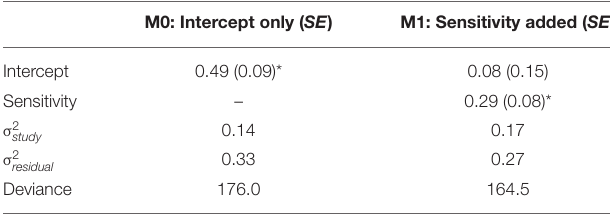
TABLE 6 | Results of multilevel analytic comparison of CM and